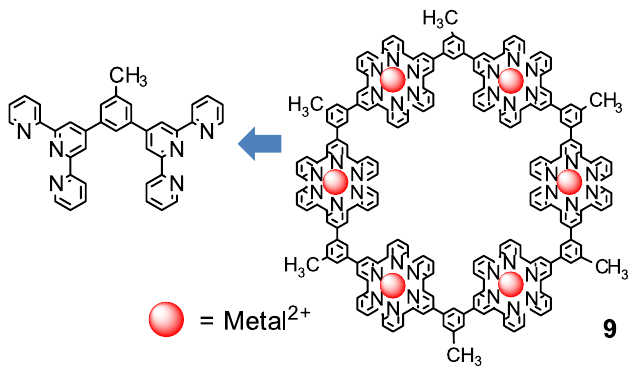
120° directionality affords a hexameric, metallomacrocycle.